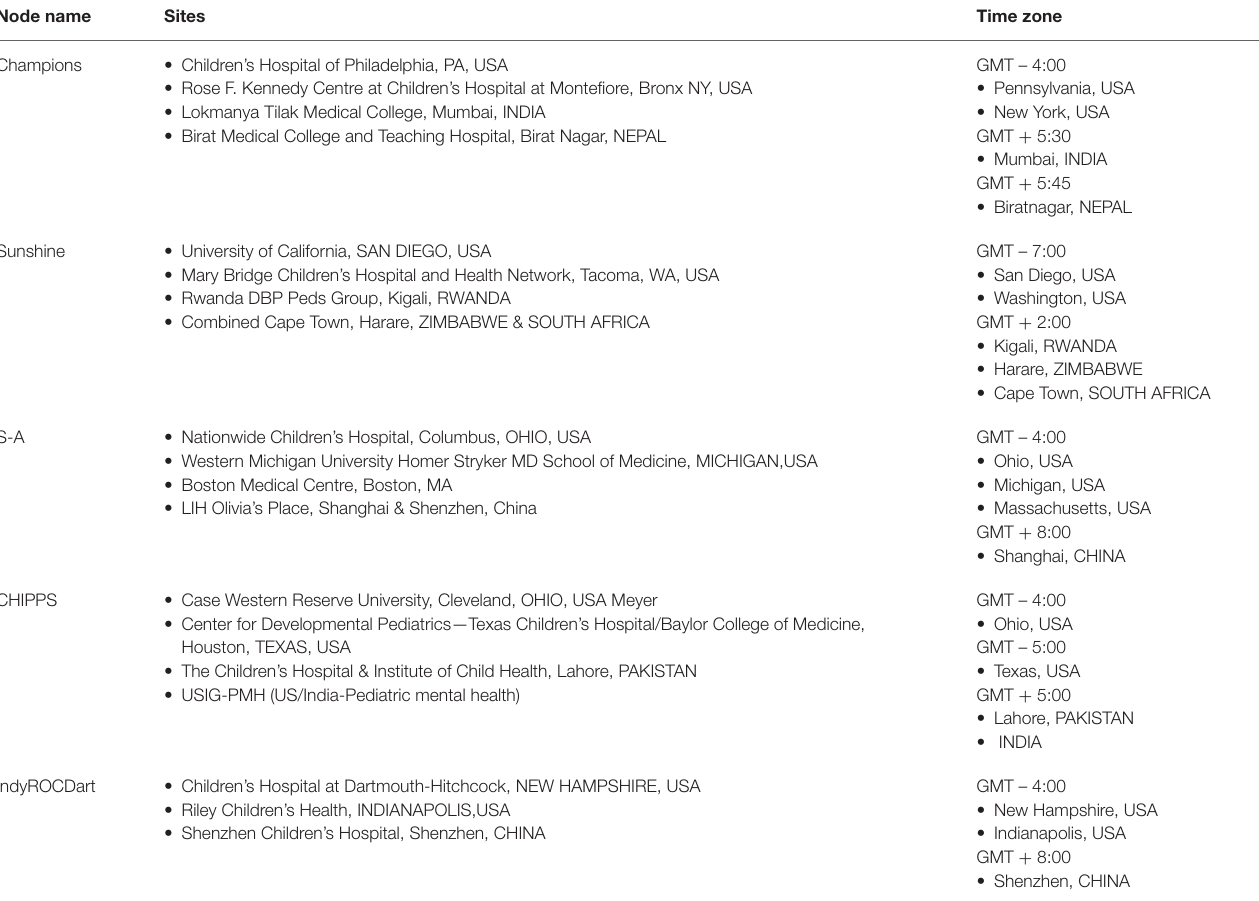
TABLE 1 | Nodes and Sites comprising the International Interprofessional Collaborative Office Rounds Program, including Time Zones for each of the sites. Node